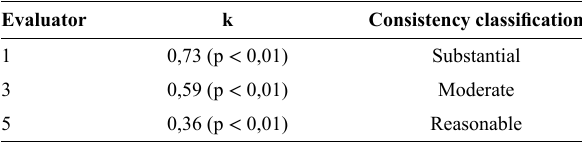
Table 3 - Intra-evaluator consistency for the items proposed on the crawl swimming technique observation sheet.